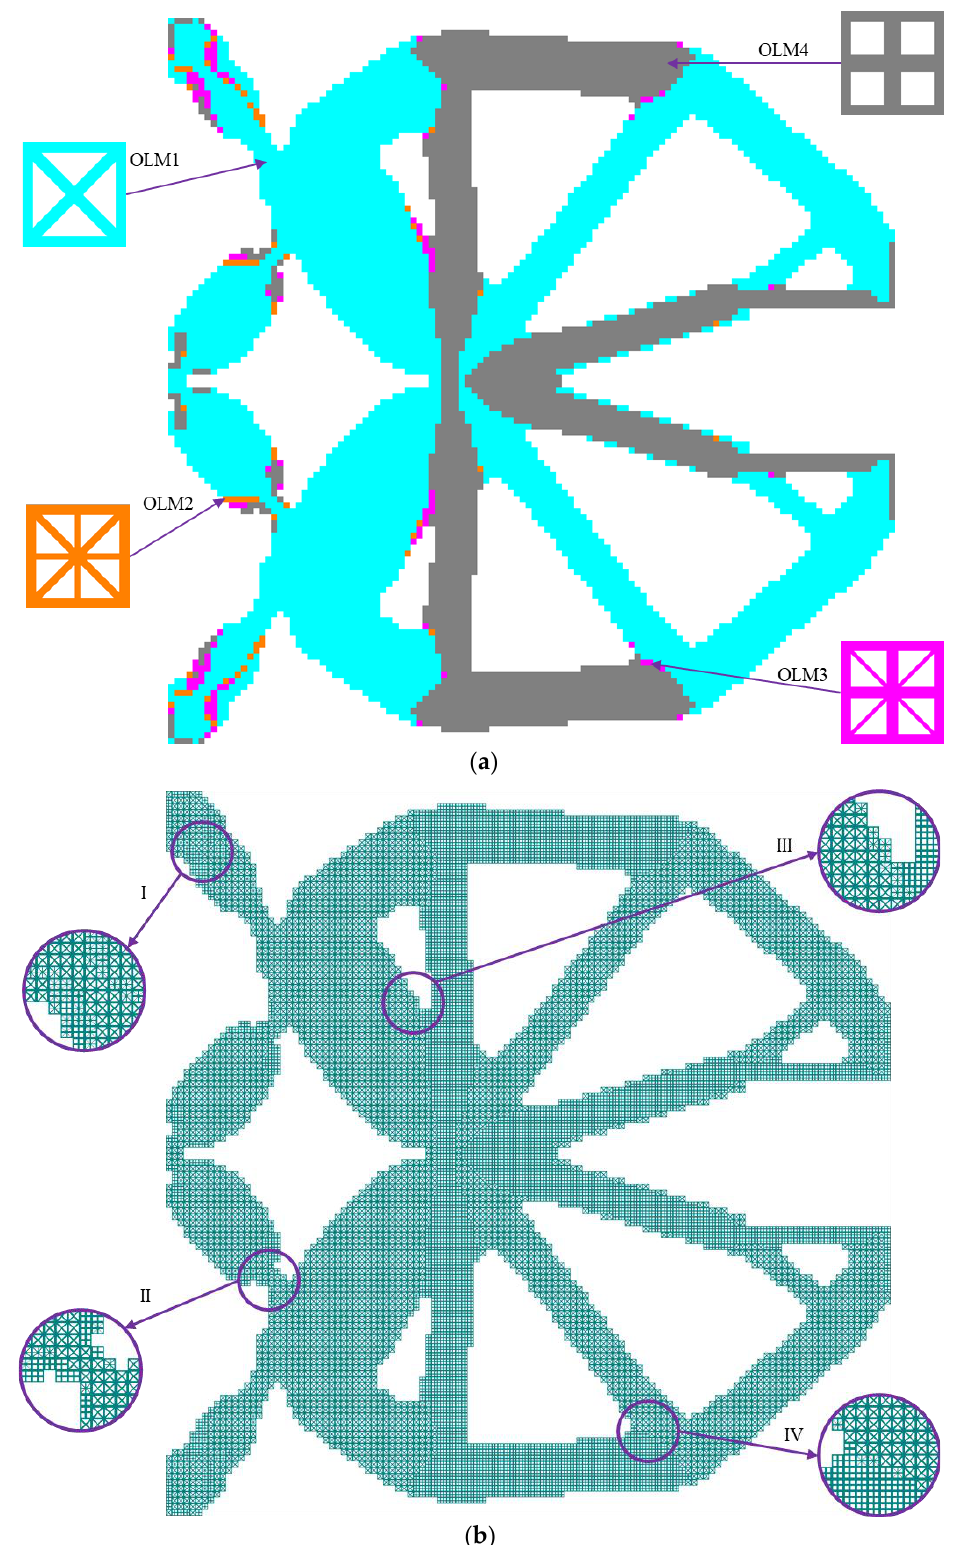
Figure 10. Iteration histories of objective output displacement and volume faction of the CGMs.